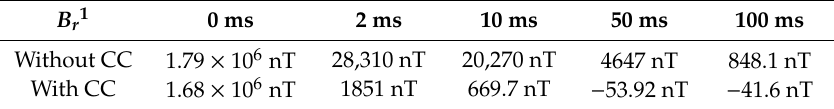
Table 3. B r without and with CC at di ff erent times.